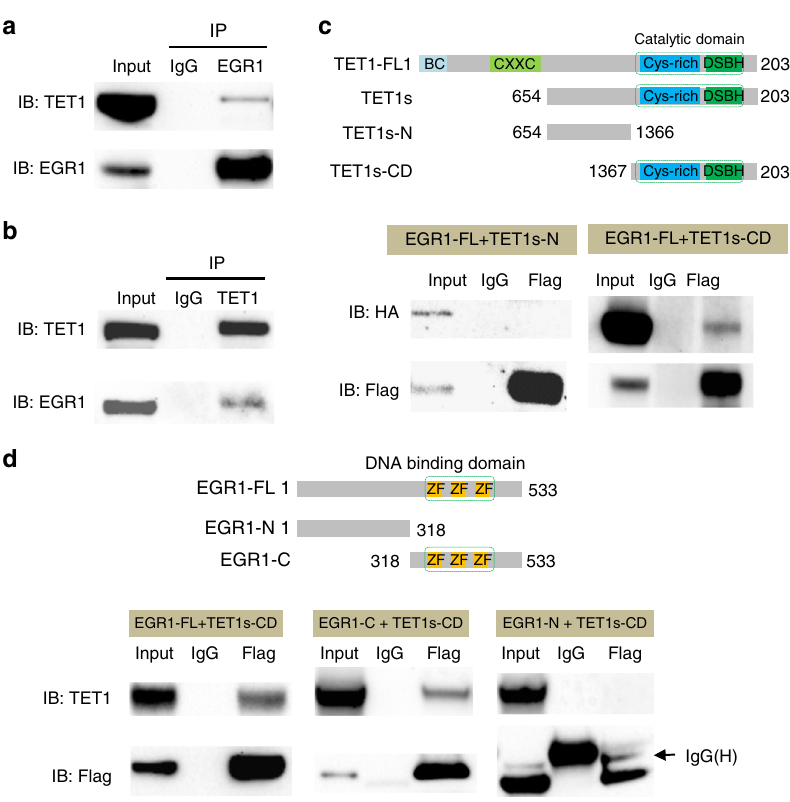
Fig. 2 Identi fi cation of the protein-protein interaction between EGR1 and TET enzymes by co-immunoprecipitation. a , b Endogenous association of EGR1 and TET proteins. EGR1 was immuno-precipitated from mouse frontal cortex, followed by western blot to detect TET1 ( a ). TET1 was immuno-precipitated from mouse frontal cortex, followed by western blot to detect EGR1 ( b ). Normal rabbit IgG served as a negative control for immunoprecipitation. IP, immunoprecipitation. c Interactions between full-length EGR1 (EGR1-FL) and TET1 deletion mutants. Flag-tagged EGR1-FL and HA-tagged TET1 deletion mutants as shown in the schematic illustration were co-expressed in HEK293T cells. d Interactions between TET1s-CD and EGR1 deletion mutants. HA- tagged TET1-CD and Flag-tagged Egr1 deletion mutants as shown in the schematic illustration were co-expressed in HEK293T cells. Protein-protein interactions were examined by IP-western blot using the antibodies indicated. Source data are provided as a Source Data fi